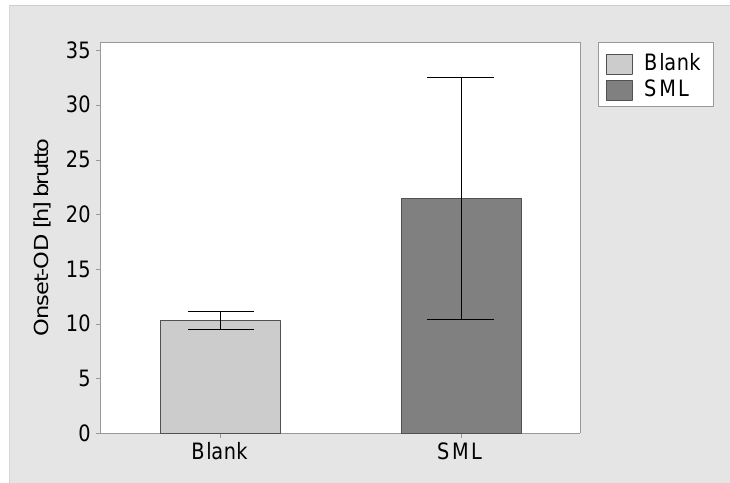
Figure 3. Results of the proliferation assay. Brutto Onset-OD time and 95% confidence interval for